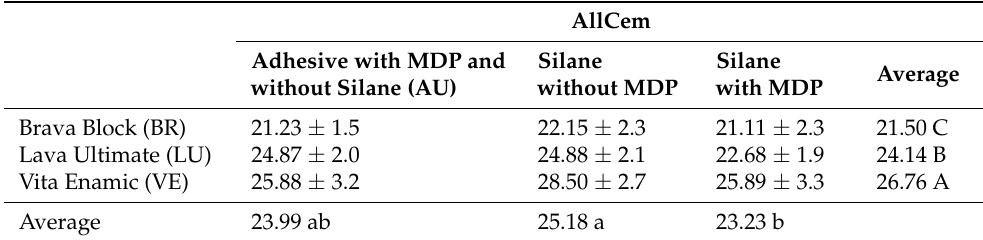
Table 3. Means and standard deviations of bond strength values (MPa) by micro-shear test with AllCem cement for the experimental groups.